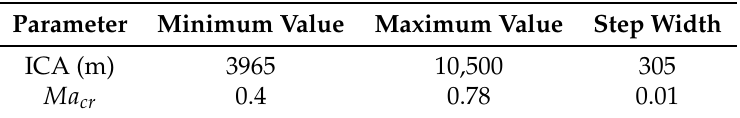
Table 6. Range of ICA and Ma cr variations applied in the present study to derive the operational mitigation potential of the redesigned aircraft.